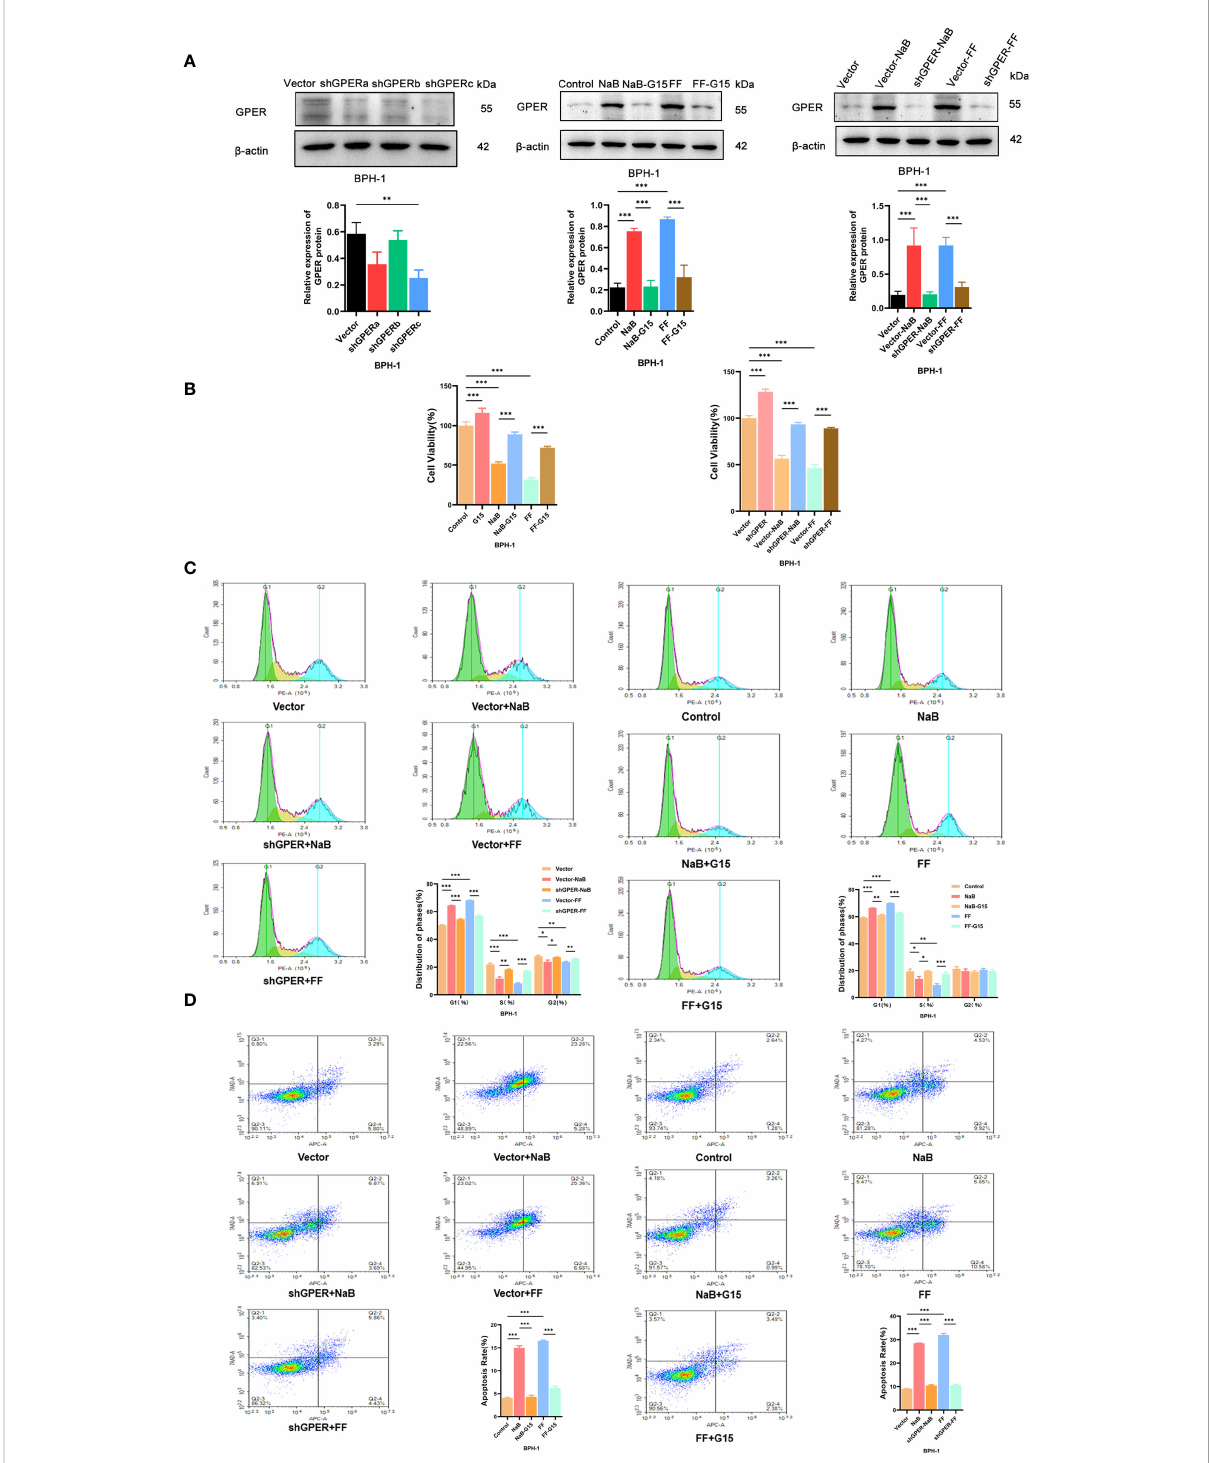
FIGURE 5 (A) . Western blot of proteins in BPH-1 cells. (B) . Cell viability assays were conducted with BPH-1 cells under different conditions. (C) . Cell cycle analysis results for the control, NaB, NaB+G15, FF, FF+G15, Vector, Vector+NaB, shGPER+NaB, Vector+FF, and shGPER+FF groups. (D) . Cell apoptosis assay results of the Control, NaB, NaB+G15, FF, FF+G15, Vector, Vector+NaB, shGPER+NaB, Vector+FF, and shGPER+FF groups. * p <0.05, ** p <0.01, *** p